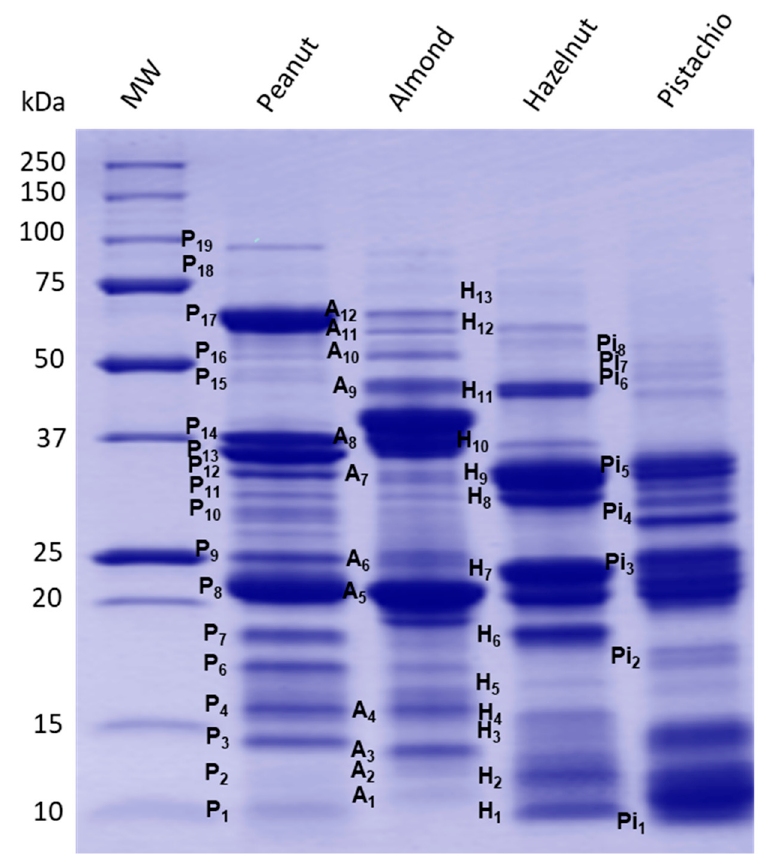
Figure 1. Reduced SDS-PAGE profile of peanut, almond, hazelnut and pistachio protein extracts.